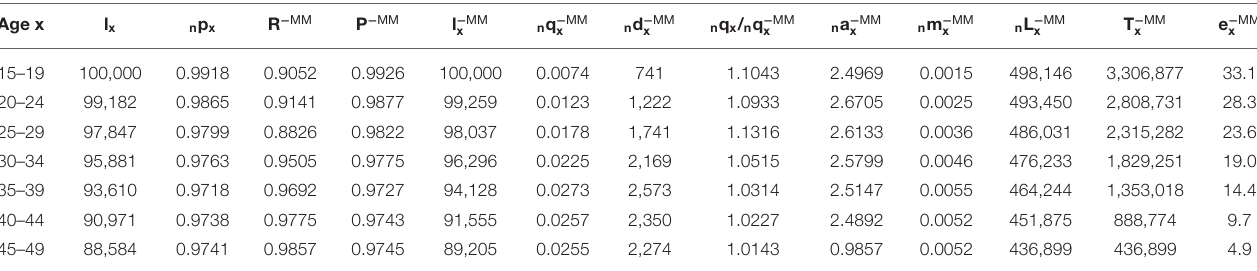
TABLE 3 | Associated single-decrement life table for causes of death other than maternal causes for Kintampo HDSS from 2005 to 2014. Age